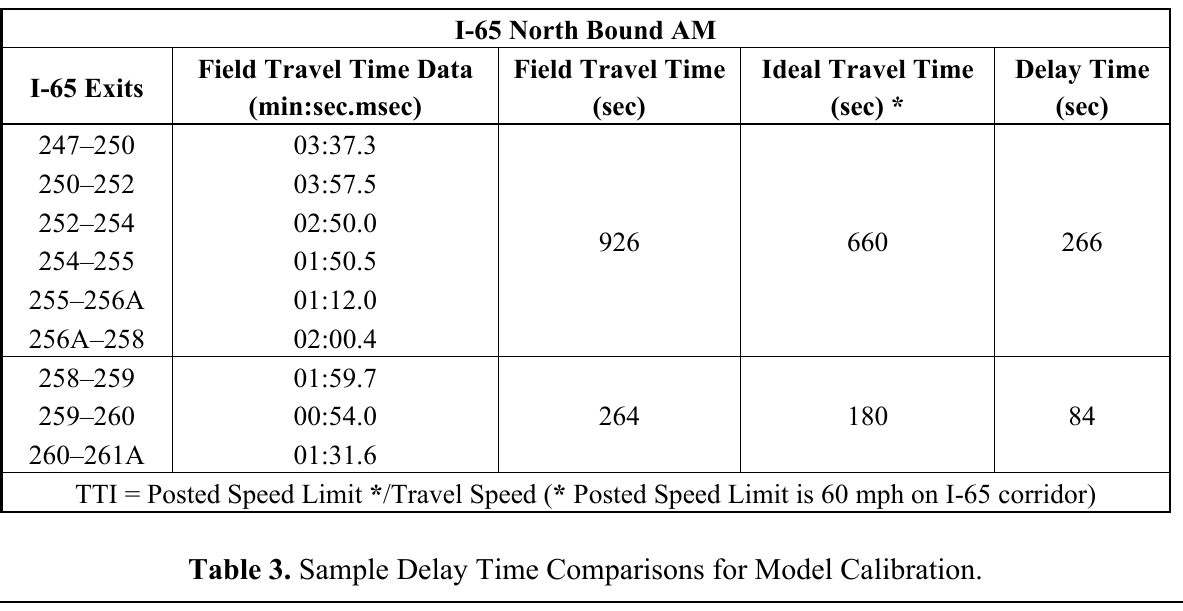
Table 2. Sample delay time calculations.